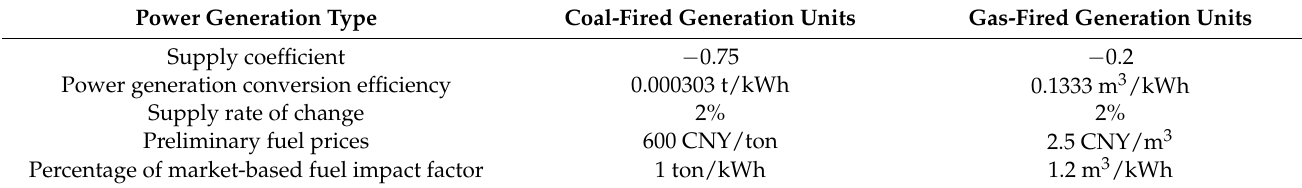
Table 2. Parameter settings for coal-fired and gas-fired generation units under the base